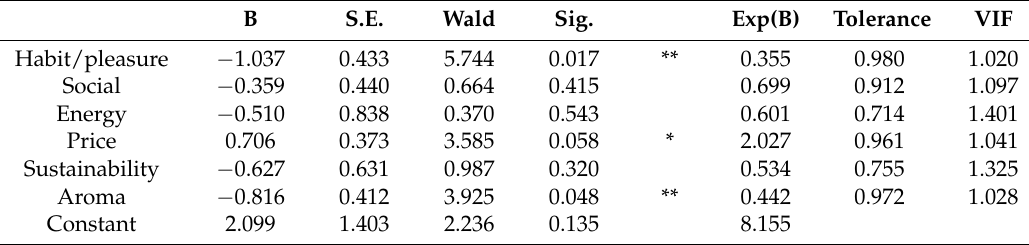
Table 7. Logistic regression on the relationship between consumers’ perception of coffee health benefits and motives for coffee consumption and purchasing.